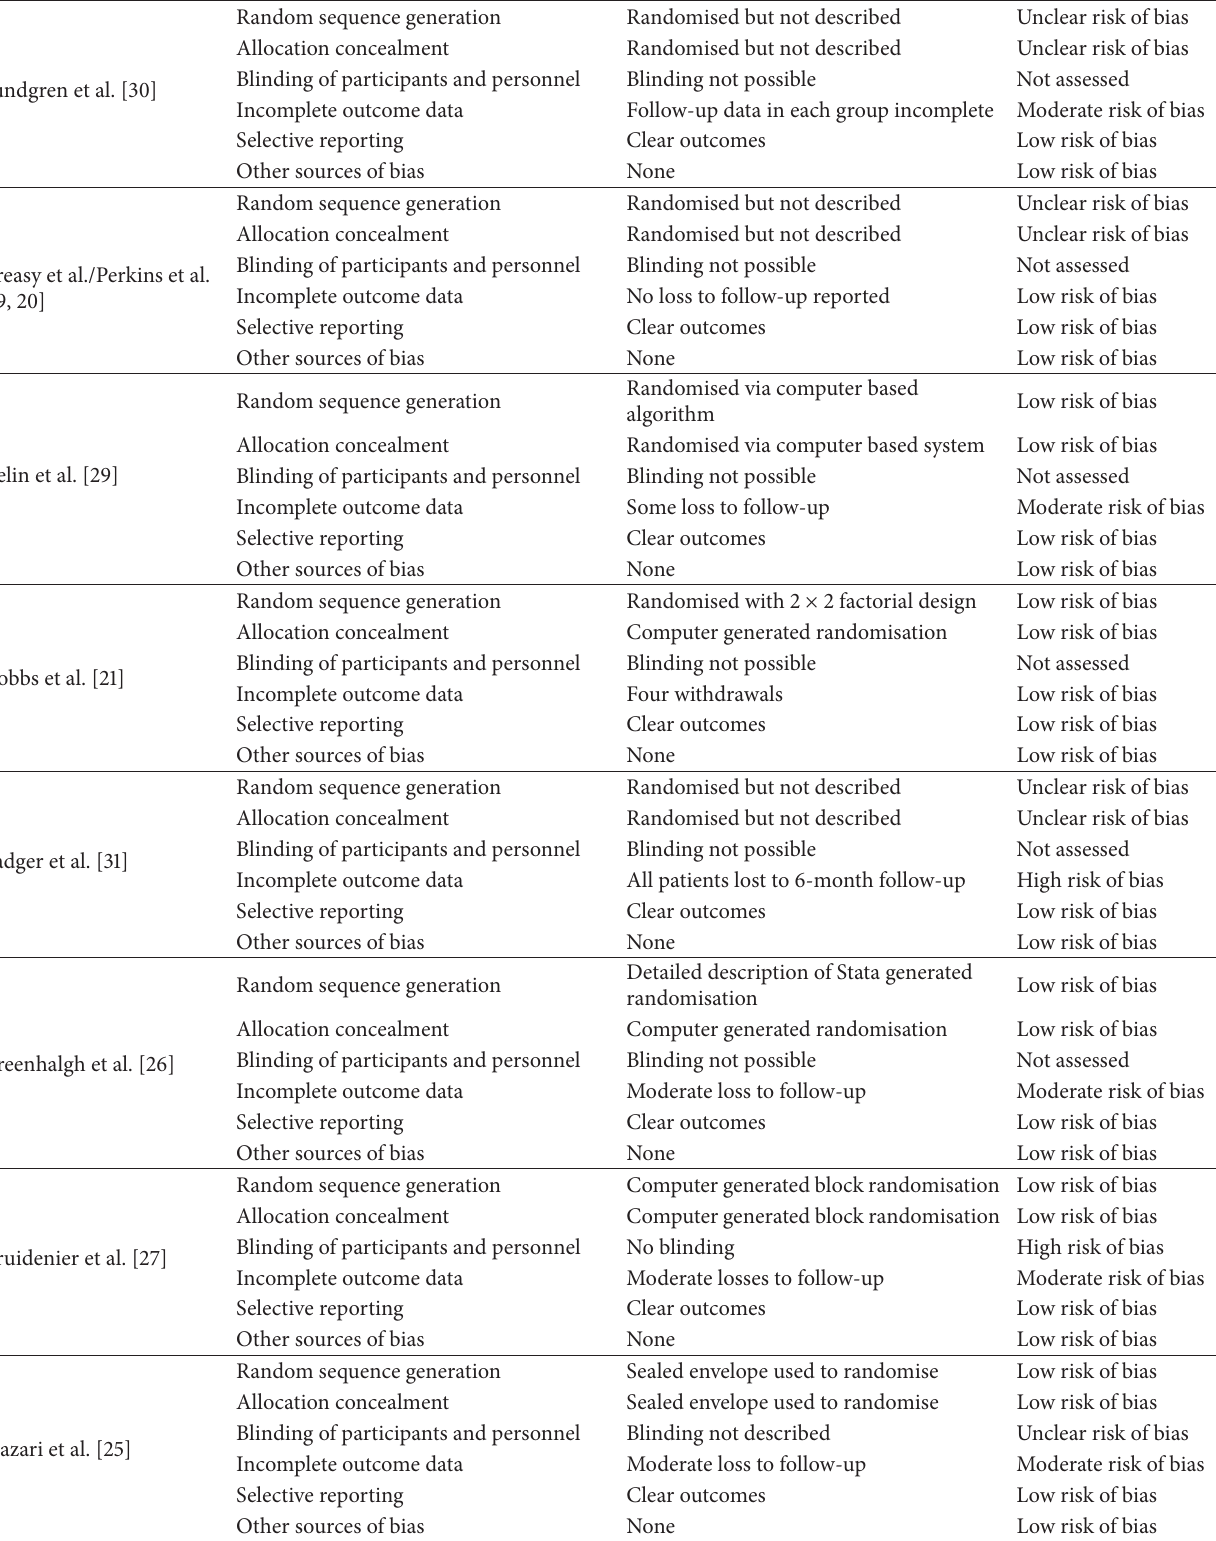
Table 2: Assessment of